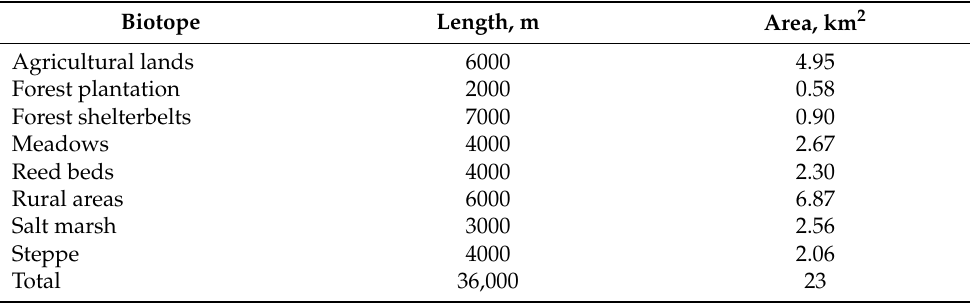
Table A1. Length of sampled transects and surveyed area.